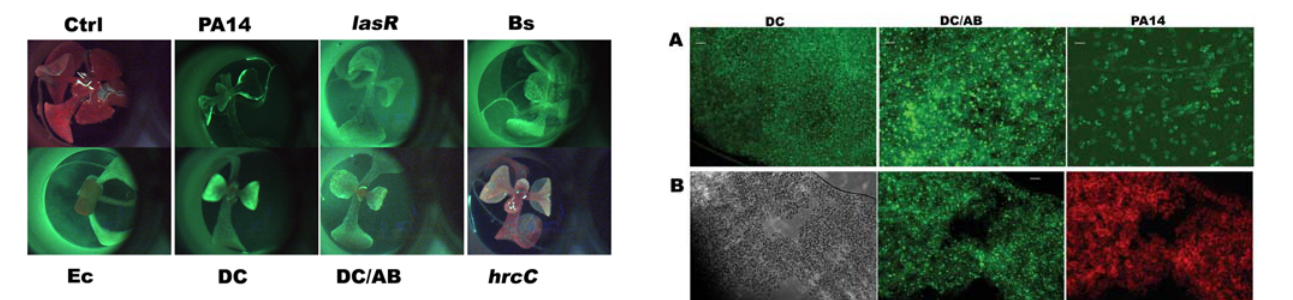
Figure 5. Characteristic cellular damage in seedlings infected with different microbes. ( A ) Seedlings were stained 3 dpi with membrane impermeable dye Sytox green after treatment with P. syringae pv. tomato DC3000 (DC), DC3000 expressing the avirulence protein AvrB (DC/AB), and P. aeruginosa PA14. ( B ) Seedlings were stained 3 dpi with membrane impermeable dye Sytox green or the membrane permeable dye Syto 59 after infection with B. subtilis , left to right: bright field, Sytox green staining, and Syto 59 staining. Scale bars indicate 50 m m.